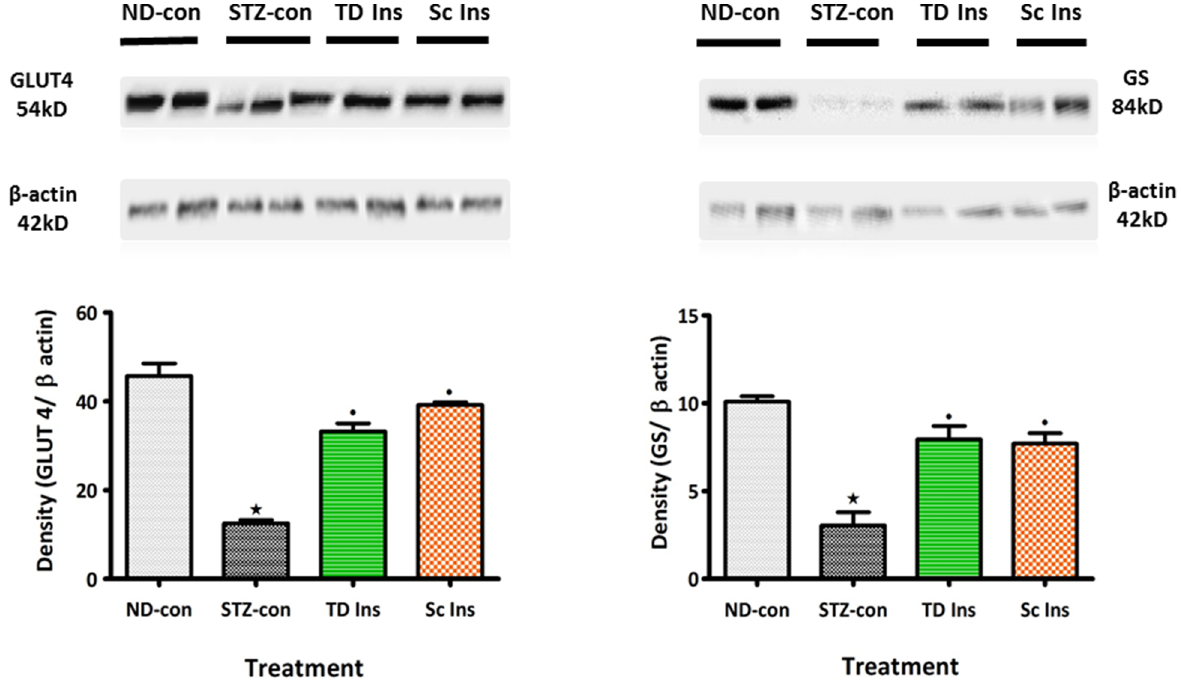
Figure 6. Comparison of the effects of topically applied PI hydrogel matrix patch and sc insulin on the the insulin-stimulated glycogen synthase (GS) and facilitative glucose transporter (GLUT4) in hepatic and skeletal muscle tissues of STZ-induced diabetic rats, respectively with untreated non-diabetic as determined by Western blotting. Values are expressed as mean 6 S.E.M. Values were obtained from Western blots for six preparations. w p , 0.05 by comparison with non-diabetic animals. control animals. doi:10.1371/journal.pone.0101461.g006 PLOS ONE |